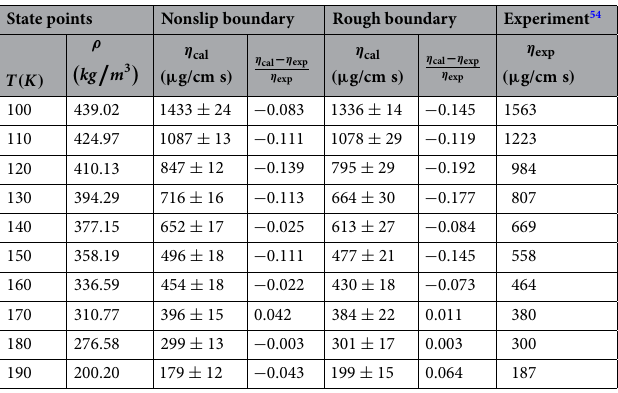
Table 3. The values and relative error of viscosity for methane nanofluidic by the presented